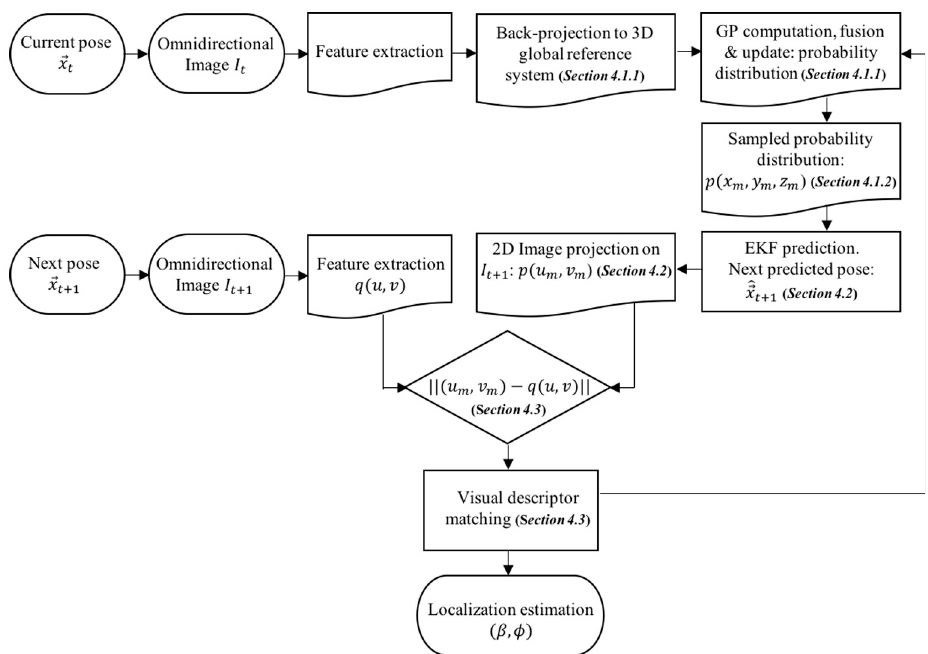
Figure 6. Block diagram of the presented